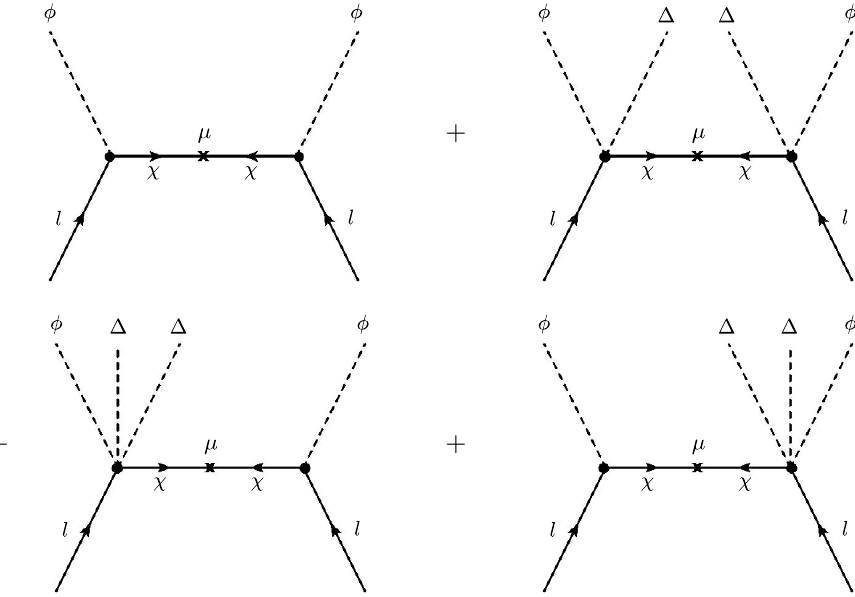
Figure 3 . Diagrammatic expansion of the tree-level integration out of (cid:31) , eq.